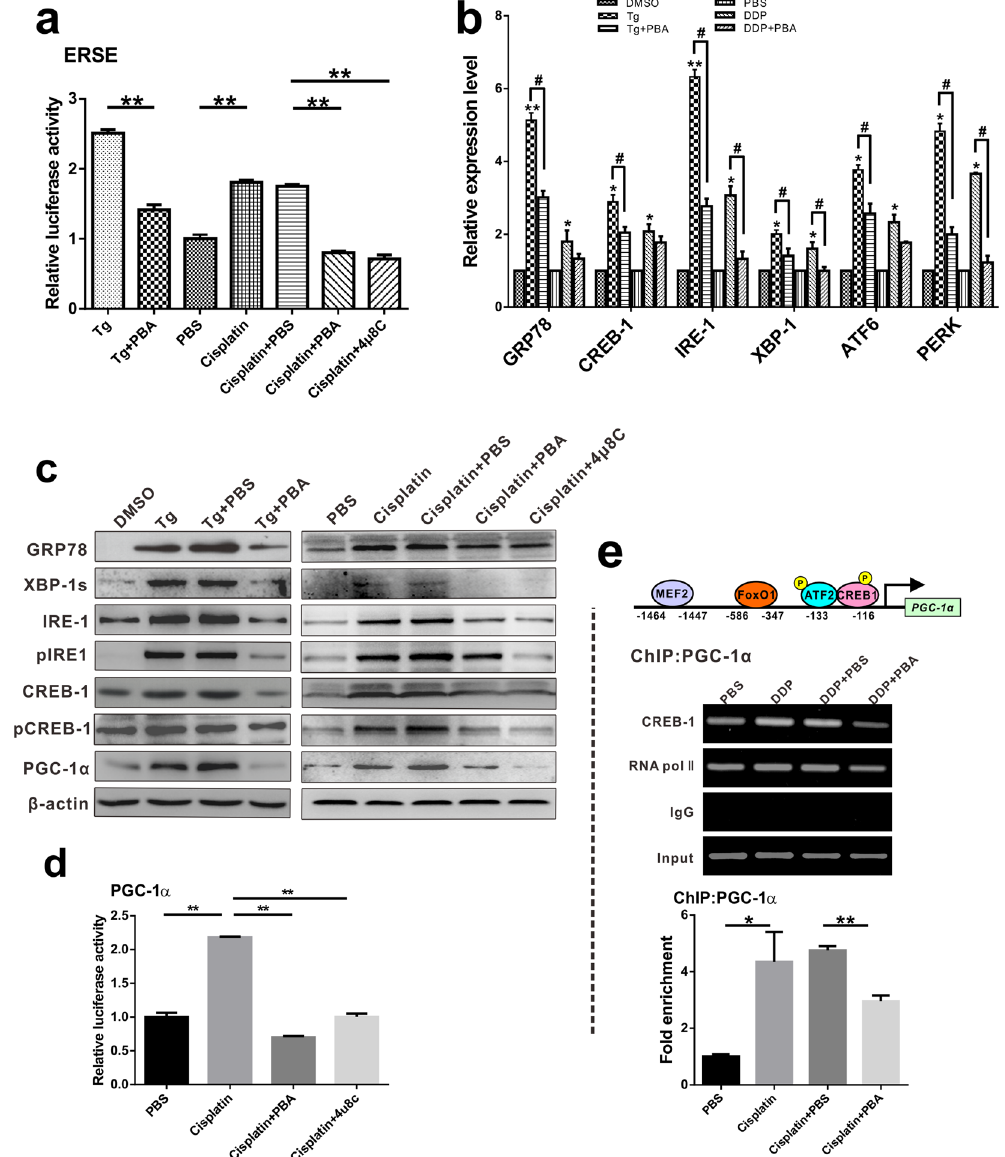
Figure 5. Cisplatin augments PGC1 α expression through ER stress in HepAD38 cells. ( a ) The luciferase activity of ER stress response elements in HepAD38 cells. ** p < 0.01. ( b ) The levels of the indicated ER inducible genes were determined by quantitative real-time PCR. HepAD38 cells were treated with cisplatin alone or cisplatin combined with 2.46 μ g/ml ER stress inhibitor (4-PBA). Data are shown as mean ± SD (independent experiments, n = 3); * p < 0.05, ** p < 0.01 vs PBS control, # p < 0.05. ( c ) HepAD38 cells were treated as described in ( b ) or treated with cisplatin combined with 0.5 μ g/ml IRE inhibitor (4 μ 8C). Protein levels of ER stress genes were analyzed by western blot. The cropped blots are used in the figure and full length blots are presented in Supplementary Fig. S9. ( d ) PGC1 α promoter activities in HepAD38 cells. Data represent the means ± SD (independent experiments, n = 3); ** p < 0.01. ( e ) Chromatin immunoprecipitation assay of extracts from HepAD38 cells. Schematic representation of the PGC1 α promoter with the MEF2, FoxO1, ATF2 and CREB1 binding sites. Quantitative PCR results are shown as mean ± SD (independent experiments, n = 3); * p < 0.05, ** p < 0.01. RNA pol II recruited on PGC1 α promoter were used as ChIP positive